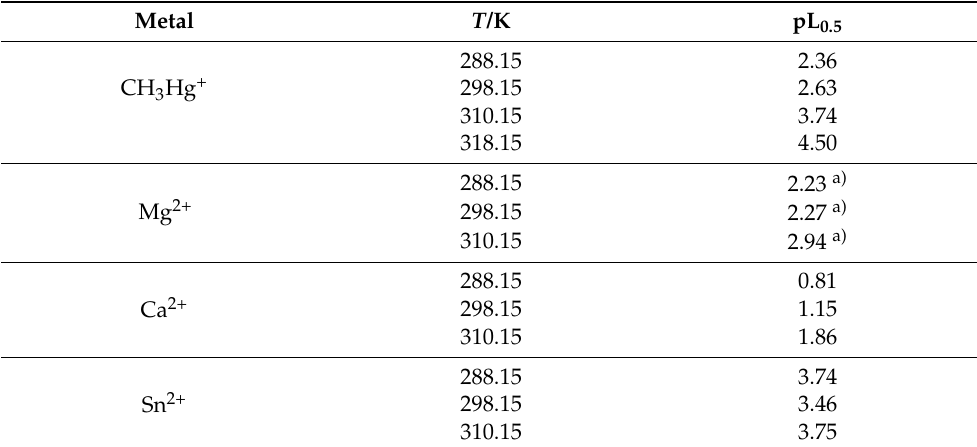
Table 11. Sequestering ability of dopamine towards the metal ions at I = 0.15 mol dm − 3 , pH = 7.4 and different temperatures.